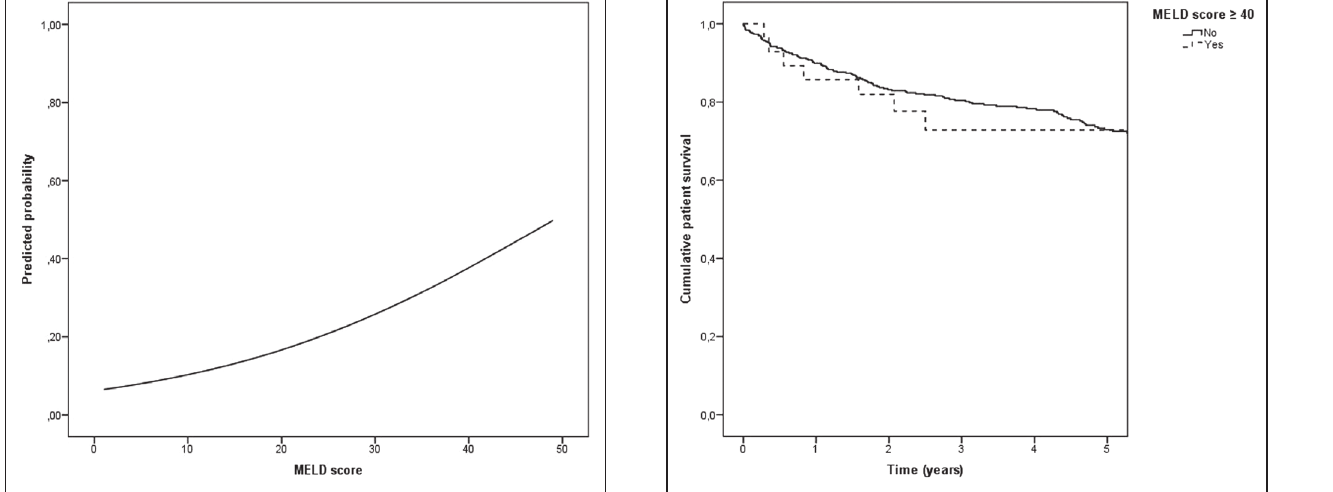
Figure 2) Unadjusted predicted probabilities of a length of first intensive care unit stay after liver transplant ≥ 10 days according to continuous biochemical Model for End-stage Liver Disease (MELD) score at liver